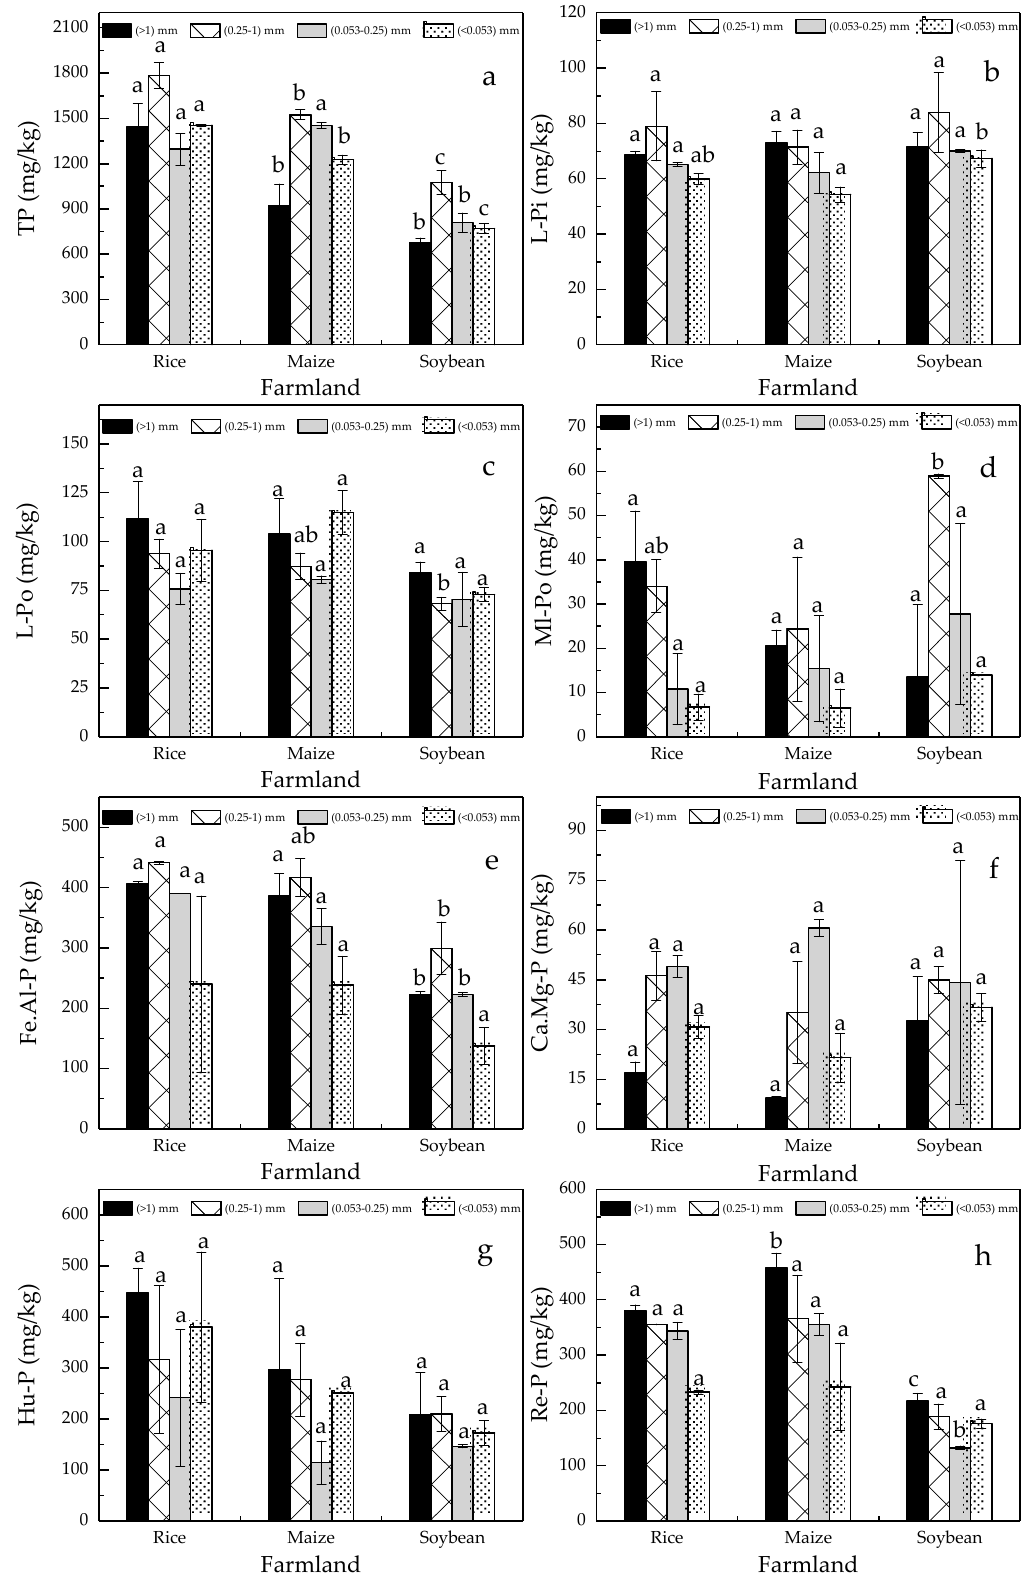
Figure 3. The content of ( a ) TP (total phosphorus), ( b ) L-Pi (labile inorganic phosphorus), ( c ) L-Po (labile organic phosphorus), ( d ) Ml-Po (moderately labile organic phosphorus), ( e ) Fe.Al-P (iron-aluminum bound phosphorus), ( f ) Ca.Mg-P (calcium-magnesium bound phosphorus), ( g ) Hu-P (humic phosphorus) and ( h ) Re-P (residual phosphorus) in soil aggregate fractions. Note: the letters a, b indicate the significant difference in the amount of phosphorus fractions in the same grain-size soil aggregate under different land